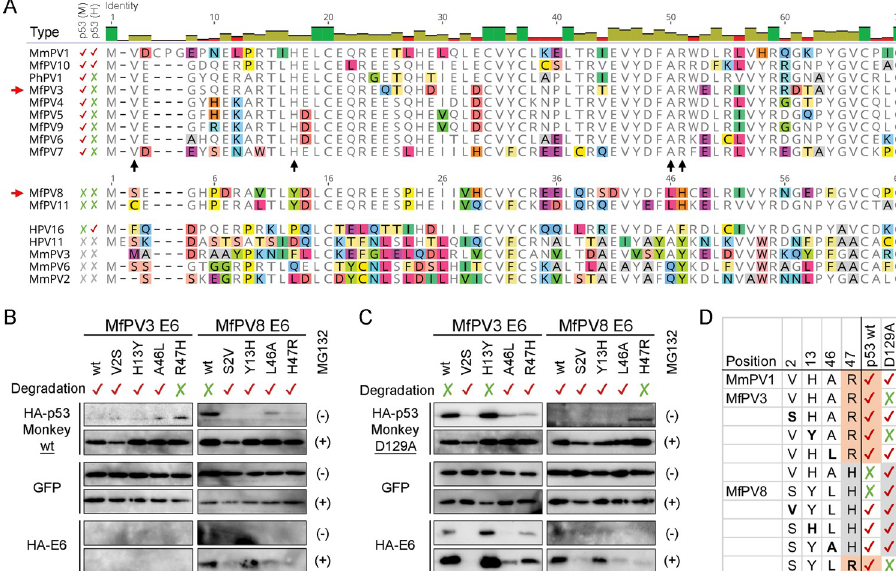
Fig 5. Macaque PV E6 mutagenesis and degradation of p53. (A) N-terminal amino acid alignment of macaque Alpha-PV E6s. Activities of the E6s to promote degradation of the wild-type monkey (M) and human (H) p53 are also indicated. Black arrows indicate columns containing homologous amino acids in α 12 degraders (Val2, His13, and Arg47) and a residue (Ala46) critical for the E6/p53 interface, whereas red arrows indicate two representative MfPV types for E6 metagenesis. (B) Degradation of the wild-type monkey p53 mediated by MfPV E6 mutants. (C) Degradation of monkey p53 D129A mediated by MfPV E6 mutants. HA-E6 and HA-p53 were co-transfected in Vero cells. (+) and (-) on the right side of the images indicate treatment with and without MG132, respectively. (D) p53 degradation patterns mediated by E6 mutants reveal an important interaction between E6 residue 47 and p53 residue